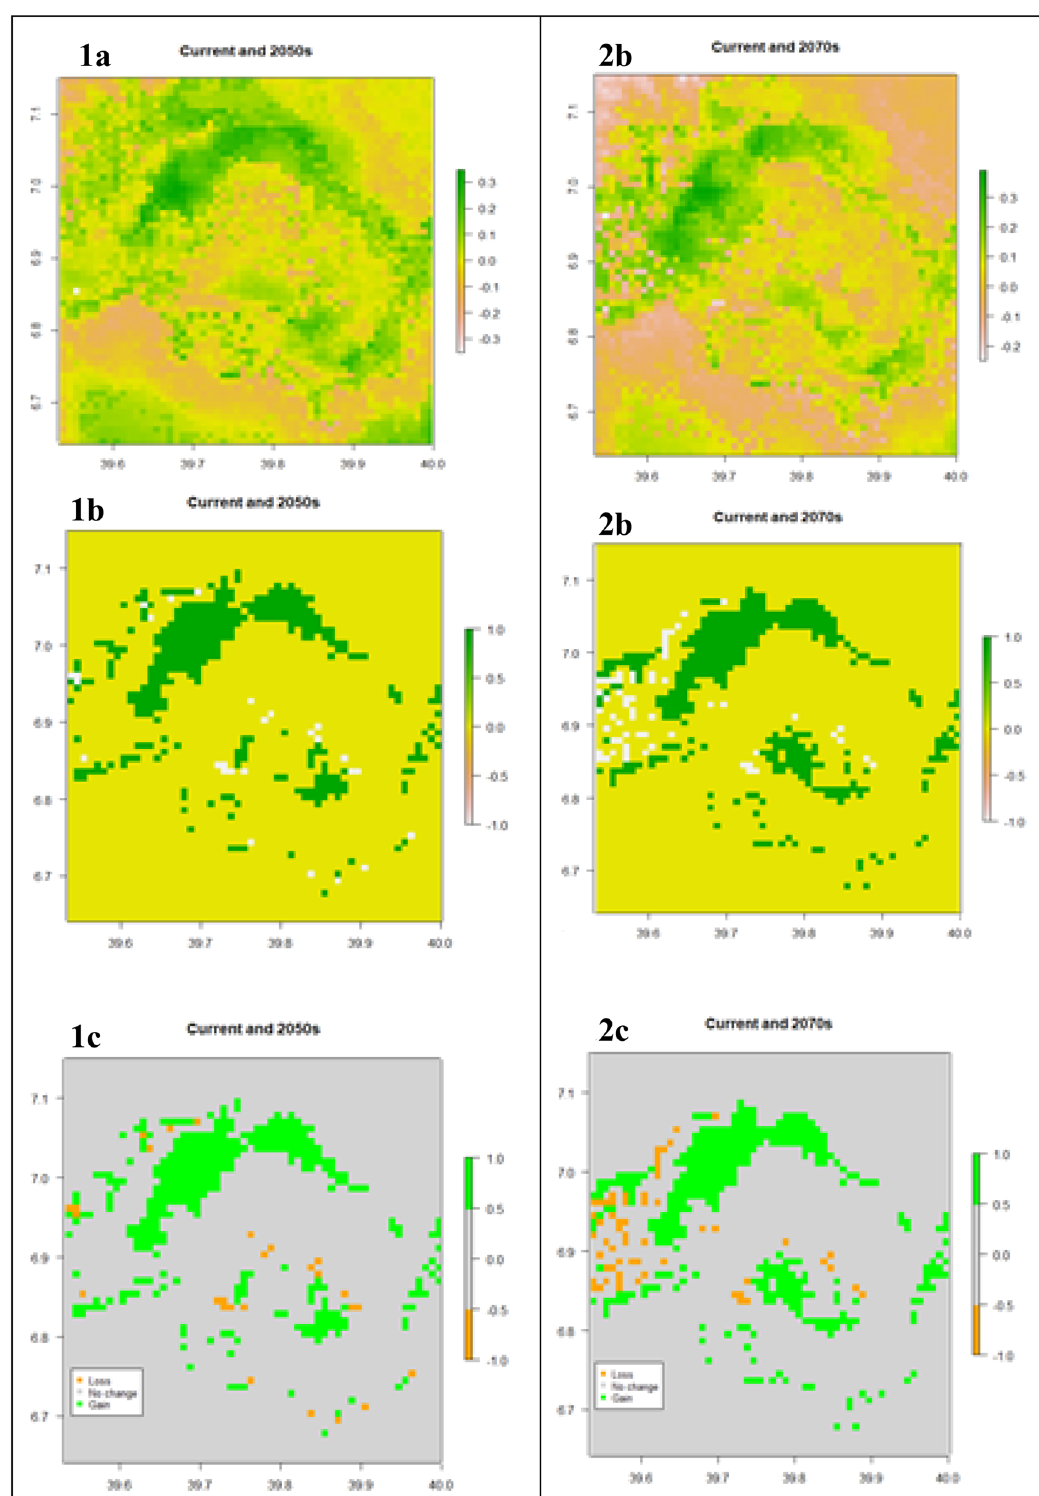
Figure 10. The difference between the averaged models’ ensembles of the three time steps [current and 2050s (Fig. 10.1), and current and 2070s (Fig. 10.2)]. and their respective presence/absence maps ( 1b and 2b color spectrum). Figure 1c and 2c presence/absence maps; a gray area represents absolute absence (unsuitable habitat), green area areas of future gain (gained future highly suitable habitats), while orange area habitat lost (current Erica habitat that will lose suitability in the future) during the span of the time